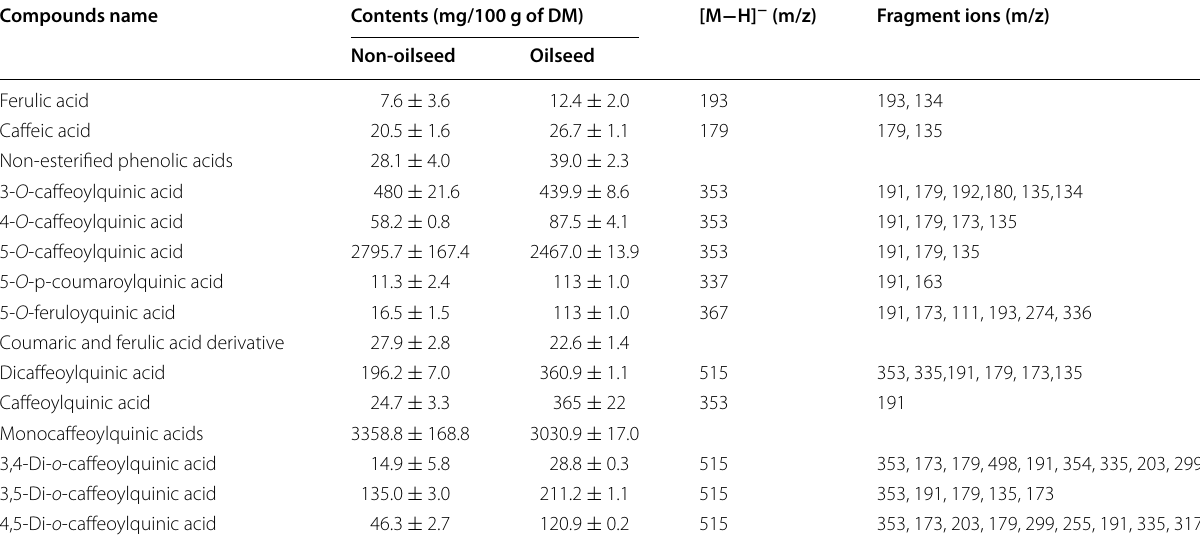
Table 2 Characteristic ions and contents of phenolic acids of sunflower seed Compounds